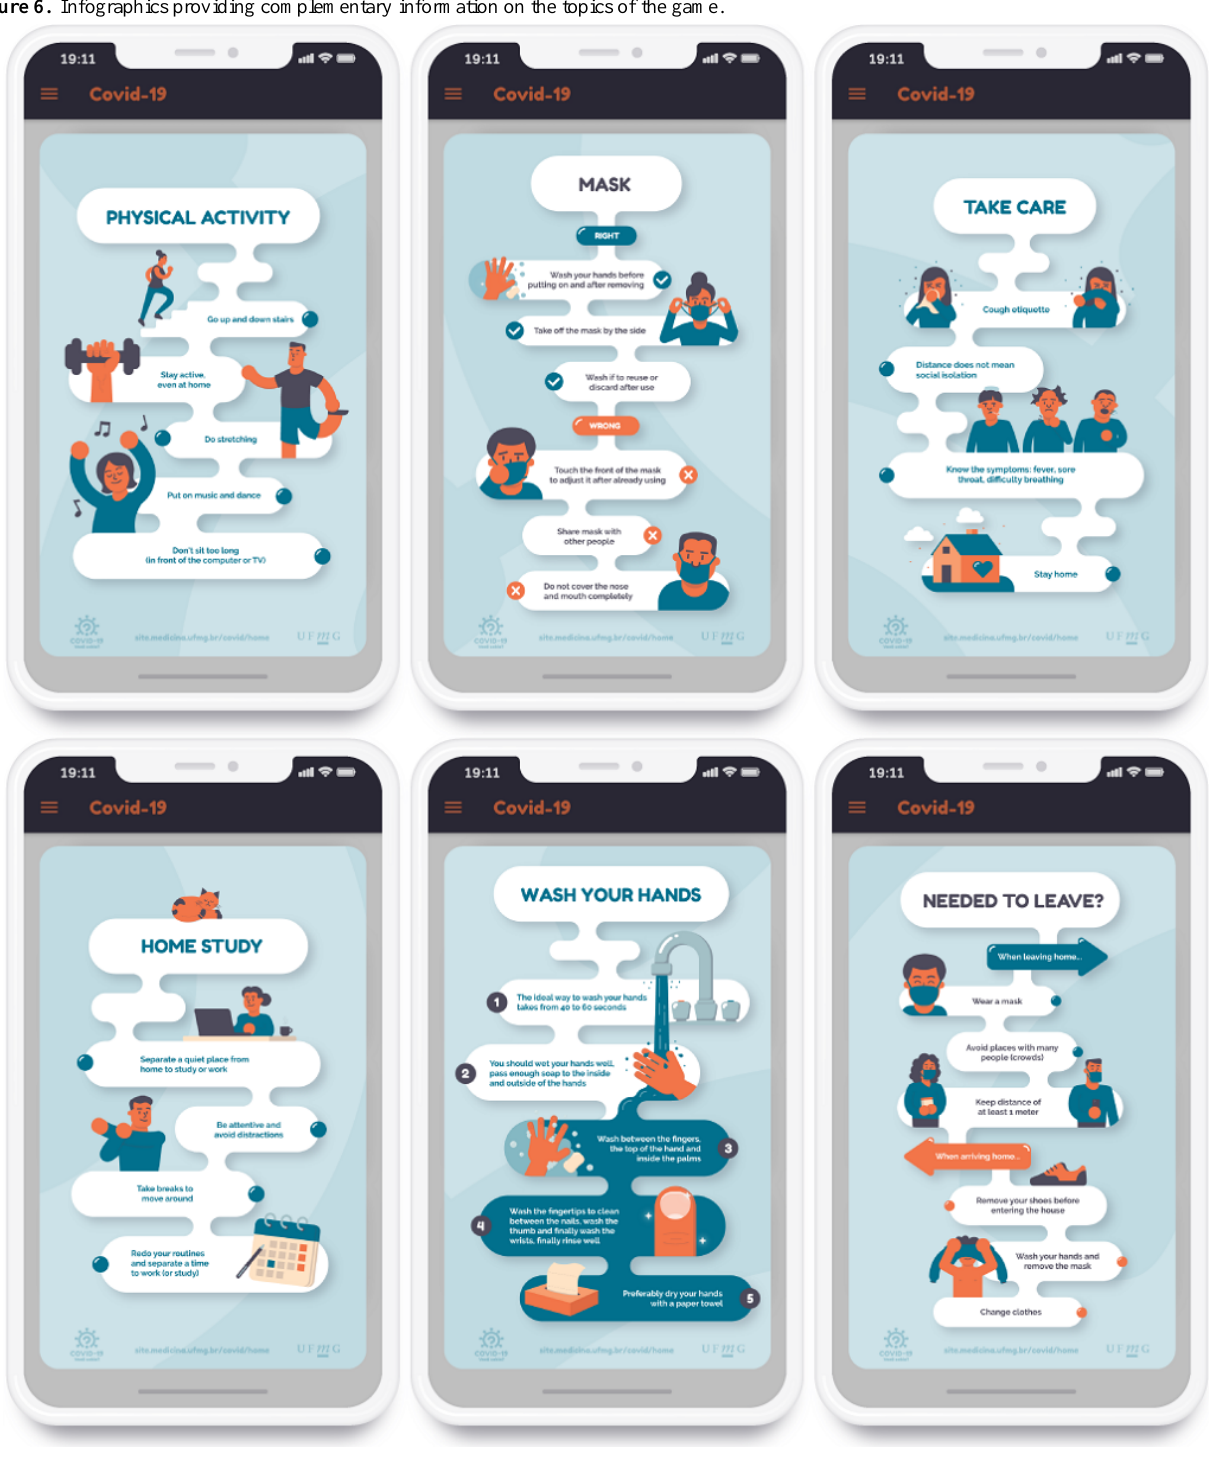
Figure 6. Infographics providing complementary information on the topics of the